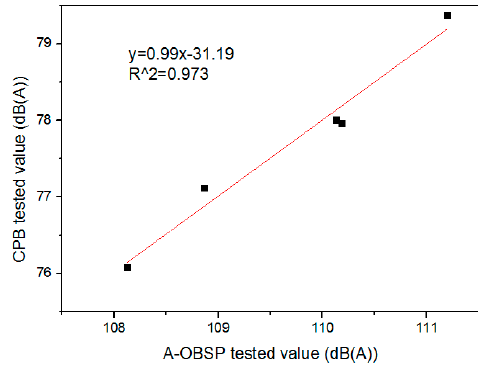
Figure 3. Tire noise correlation of CPB and A-CPX methods.